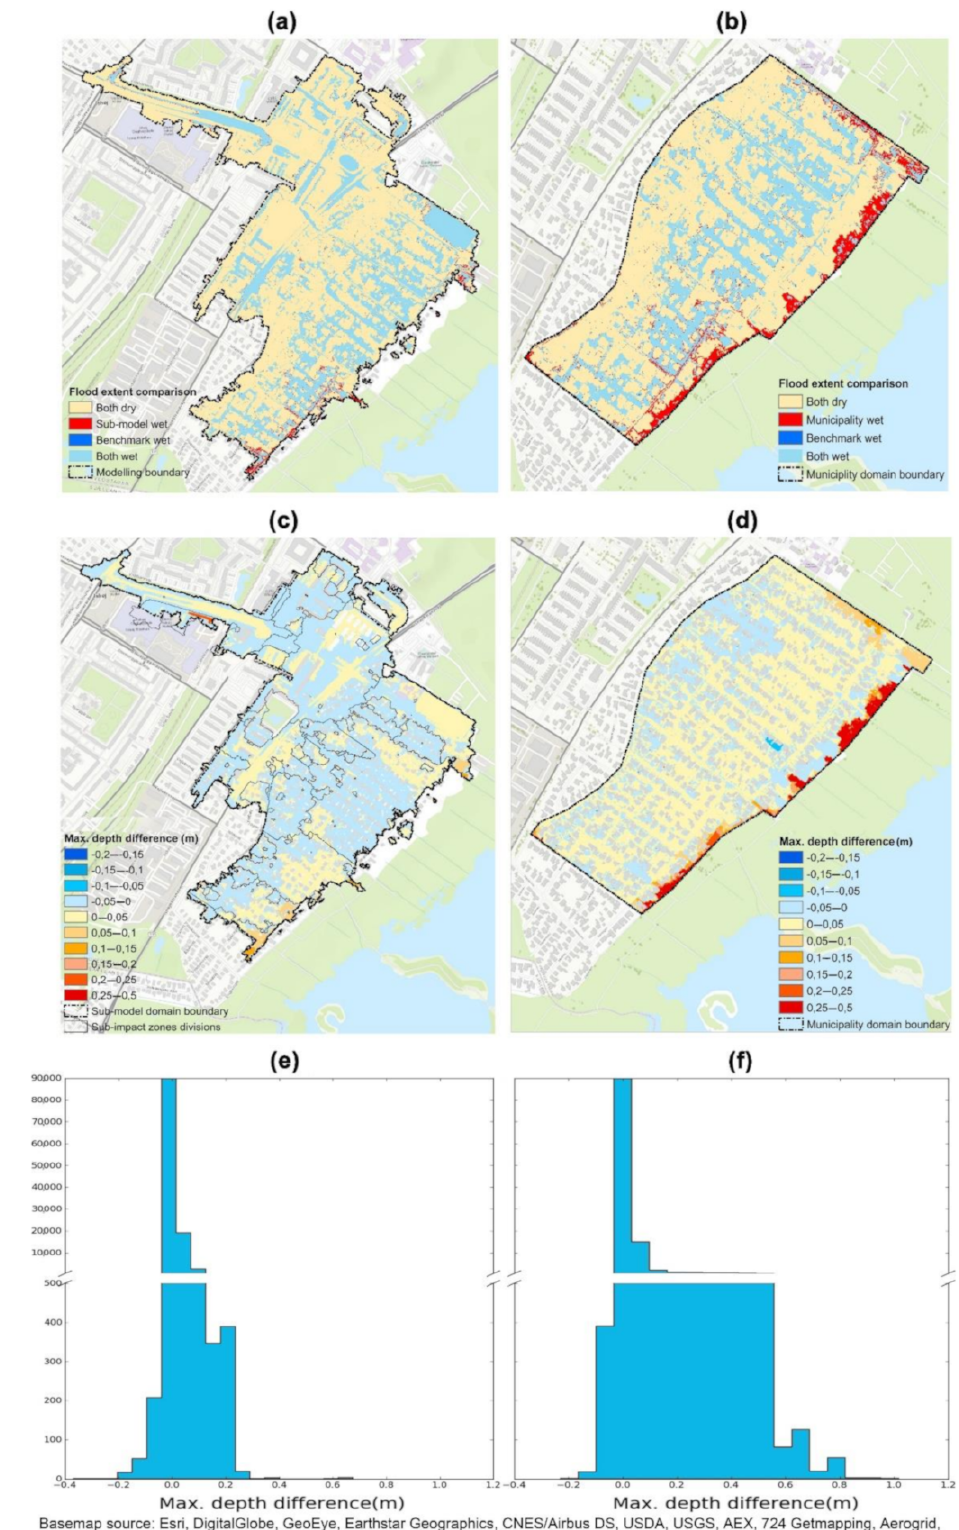
Figure 9. Benchmarking discrepancies in Max. depth flood extents: ( a ) Sub-model approach’s categorised map, ( b ) Municipality domain approach’s categorised maps. Benchmarking discrepancies in Max. flood depths: ( c ) Sub-model approach’s depth difference map, ( d ) Municipality domain approach’s depth difference map, ( e ) Sub-model approach’s histogram of Max. depth difference, ( f ) Municipality domain approach’s histogram of Max. depth